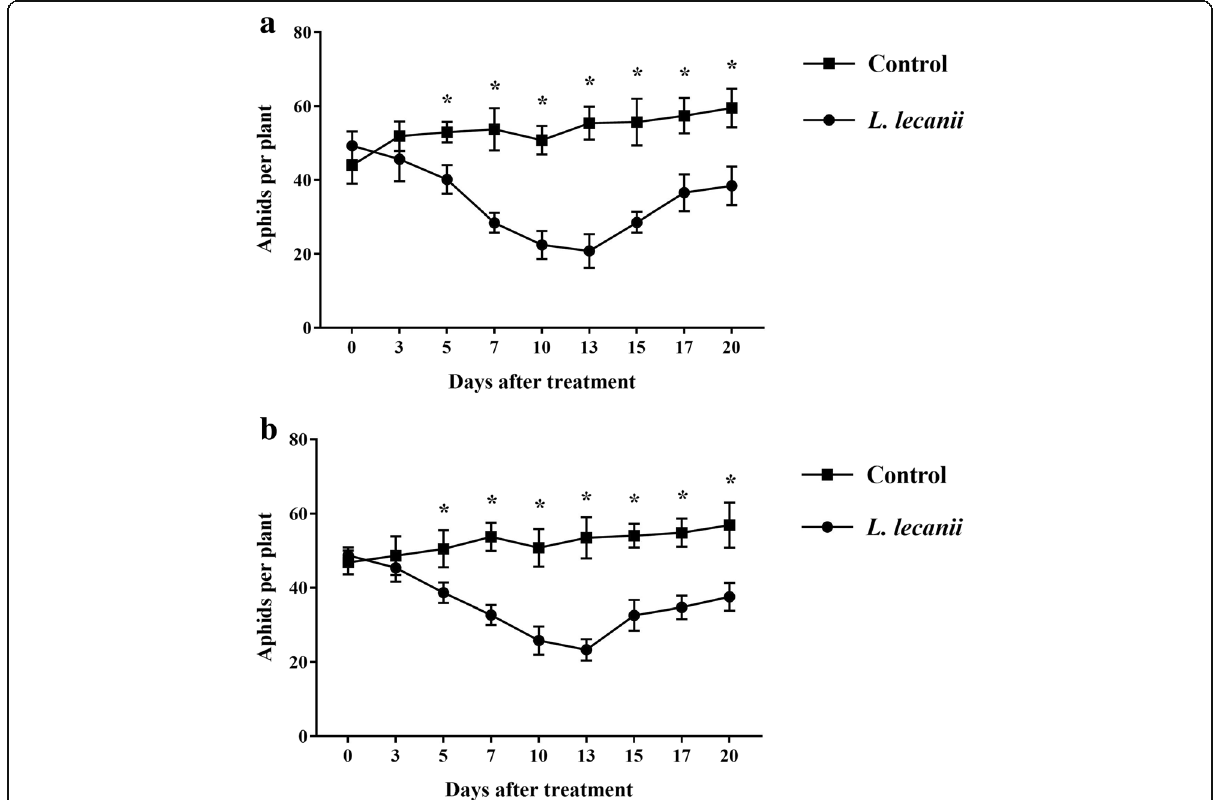
Fig. 3 Effect of L . lecanii isolate (1 × 10 8 conidia ml − 1 ) on the numbers of a M . persicae and b A. gossypii (mean ± SE) compared with the control on cucumber plants at different days post-treatment in the greenhouse. Bars represent the standard errors of the means. Treatments marked with asterisks are significantly different from the corresponding control in the values at P < 0.05, using Tukey ’ s